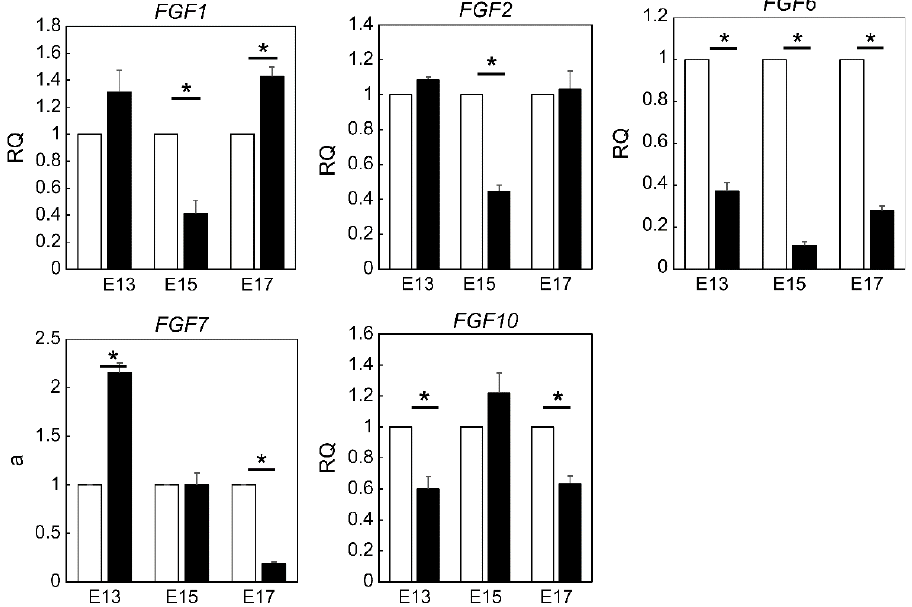
Figure 2. Gene expression of FGF family members during the wound healing process in mouse fetuses. *, p < 0.05. RQ, relative quantification. FGF, fibroblast growth factor 7. 2.3. Role of FGF7 in the Wound Healing Process in Mouse Fetuses